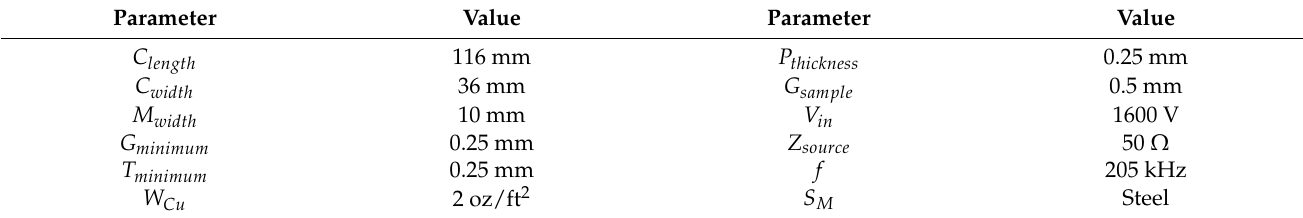
Table 1. Parameter input values for the unidirectional transmitter